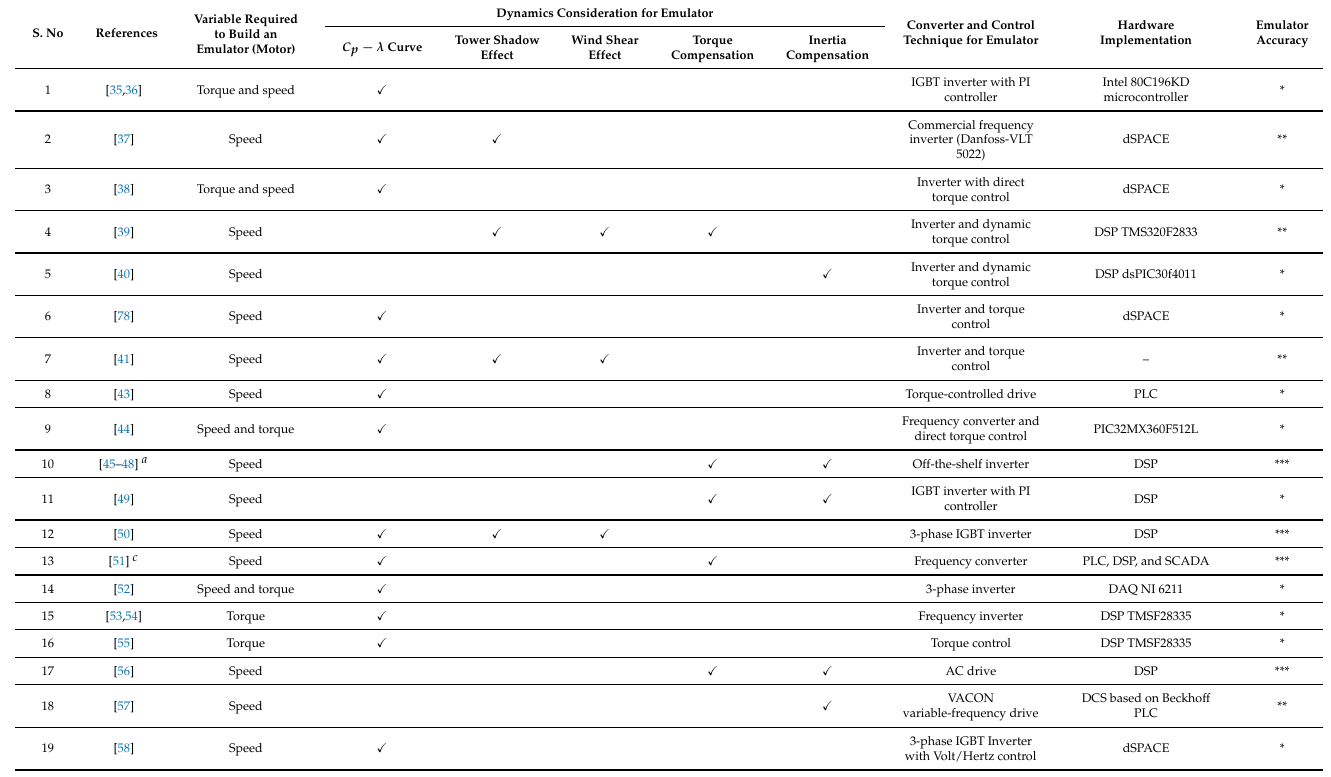
Table 2. Comparative analysis of different WTEs based on induction